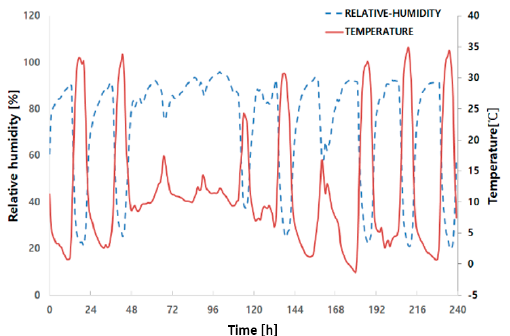
Figure 6. Relative humidity and ambient air temperature.